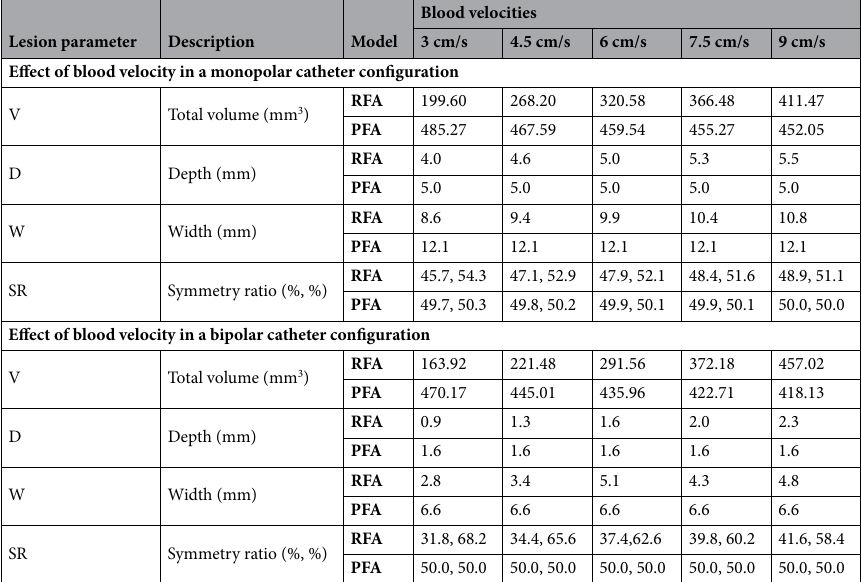
Table 2. Effect of blood velocity on lesion parameters for the monopolar and the bipolar catheter configuration. Total volume (V), depth (D), width (W) and symmetry ratio (SR) of the